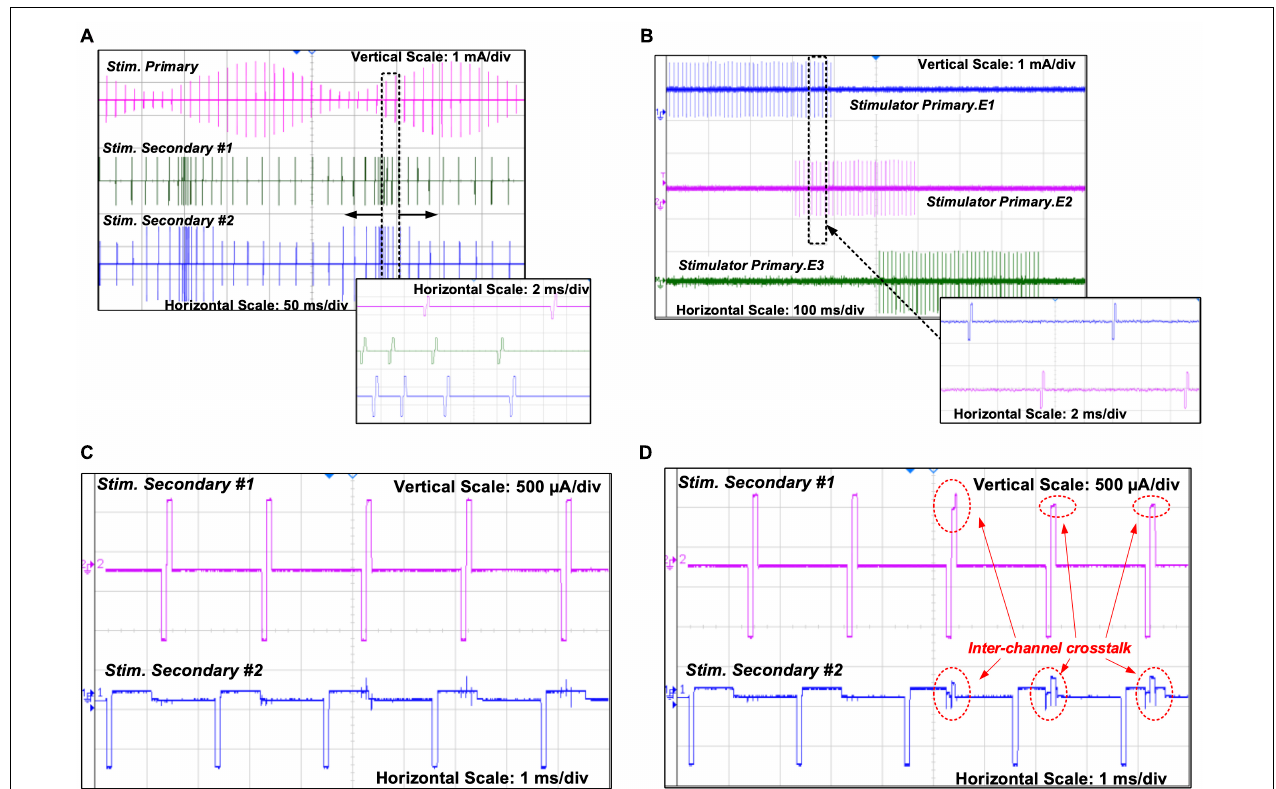
FIGURE 8 | In vitro electrical performance evaluation: (A) Parallel stimulation on the three stimulators in different modes of modulation; (B) Pulses multiplexed among electrodes on the primary stimulator; (C) Concurrent stimulating pulses from the two secondary stimulators with minimized crosstalk; (D) Concurrent stimulating pulses from a benchtop setup with the same circuits but without the power-isolation scheme.